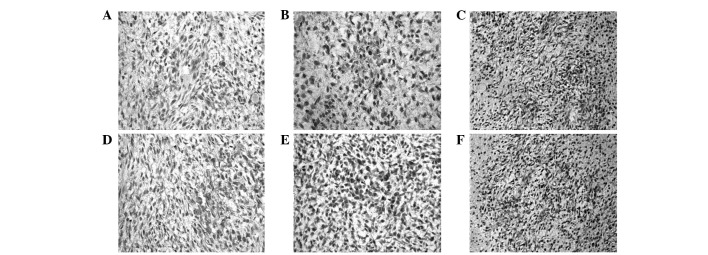
(A) MMP-2, (B) MMP-9 and (C) β-catenin protein expression in juvenile rats; (D) MMP2, (E) MMP-9 and (F) β-catenin protein expression in adult rats.